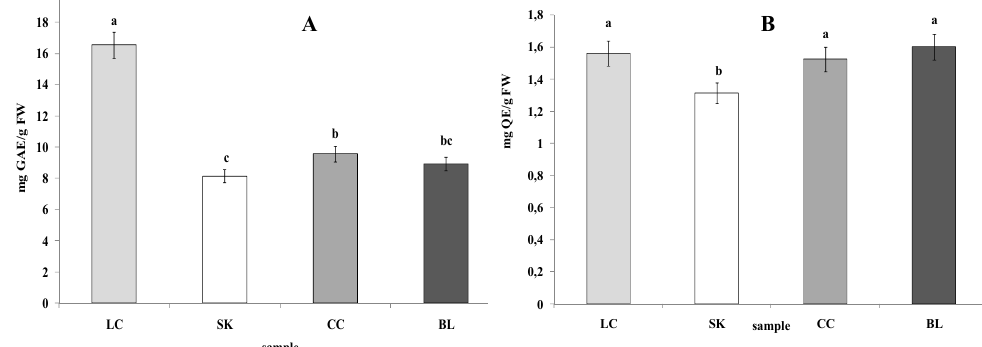
Figure 2. Phenolics ( A ) and total flavonoids content ( B ) in leaves of red chard (LC), white beetroot (SK), red beetroot (CC), and white chard (BL). Results are presented as the mean ± SD; the values designated by the different small letters (a, b, c, d) are significantly different ( α = 0.05).